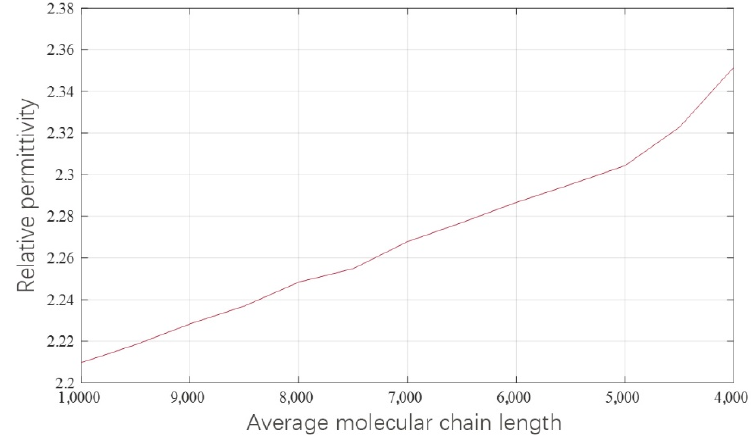
Figure 7. The curve diagram of the change of the dielectric constant with the average molecular chain length.